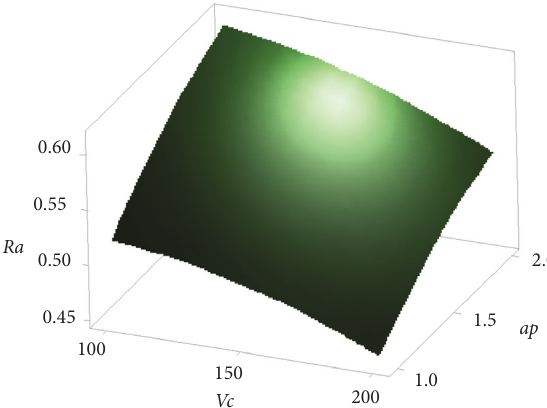
Figure 6: Predicted RSM values for surface roughness on Vc and ap .